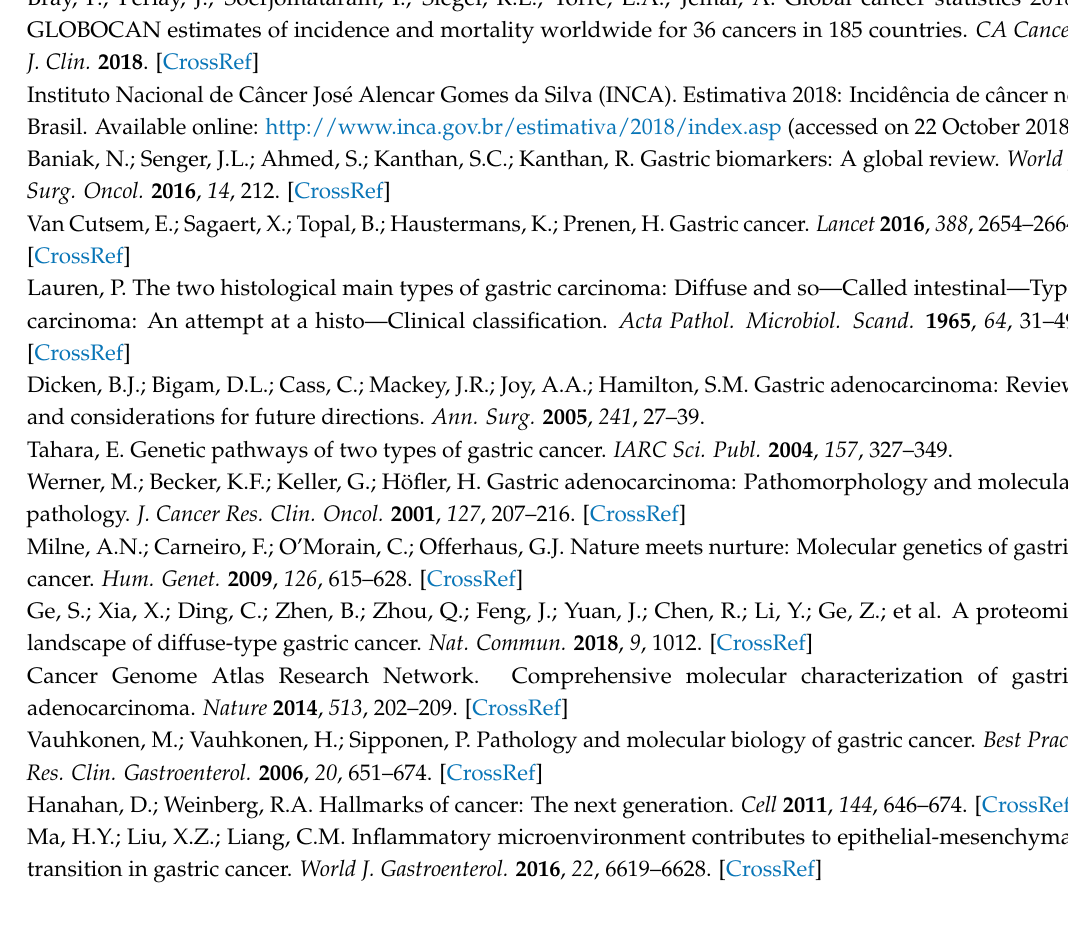
cancer susceptibility. Table S4. Clinicopathological characteristics of the cases with gastric cancer at the time of diagnosis in the total sample and stratified by Lauren’s histological subtypes and results of the comparison of these parameters between Diffuse and Intestinal subtypes. Figure S2 Representation of the haplotype blocks whose polymorphisms were found in linkage disequilibrium (LD) in the subgroup of cases with gastric cancer. Table S5 Polymorphisms in linkage disequilibrium in the sample of cases (N = 178) and haplotype association analyses with anatomopathological features of gastric cancer patients. Table S6 Overall and Disease-free survival by anatomopathological features, stratified for the cases with the diffuse histological subtype (N = 112). Table S7 Overall and Disease-free survival by anatomopathological features in the total sample of gastric cancer patients (N = 178). Table S8 In silico prediction for the functional effect in the final coded protein for the studied polymorphism that lead to amino acid change. Text S1 Discussion of the polymorphisms that did not present any relevant association in our